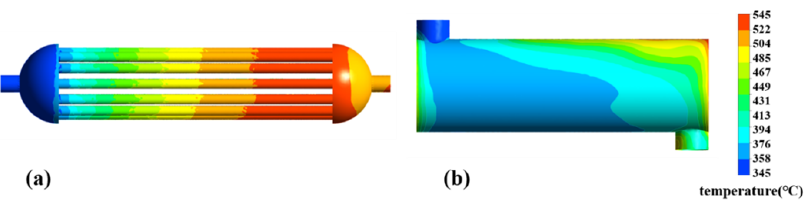
Figure 9. Water vapor temperature distribution diagram when the heat transfer working medium in the superheater is located at different positions. ( a ) Water vapor is on the tube side. ( b ) Water vapor is on the shell side.